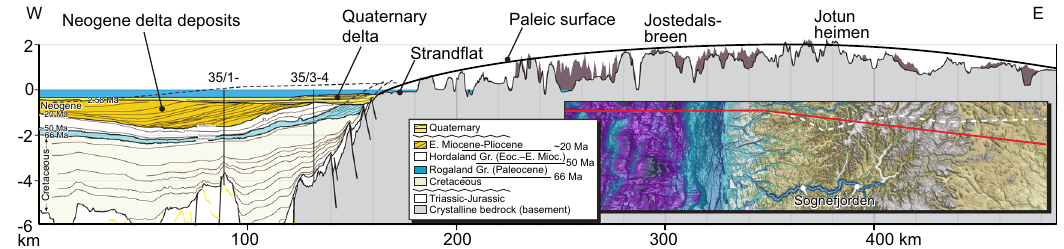
Fig. 6 Regional section through South Norway-North Sea, with location map. Offshore data show a km-thick wedge of Neogene delta deposits (20 – 2.58 Ma), downlapping onto Paleogene strata and unconformably overlain by Quaternary deposits. Inset map shows line location on a top crystalline bedrock map. Red line marks the main section, while white dashed line marks a secondary pro fi le, projected onto the main section and shown in darker color.